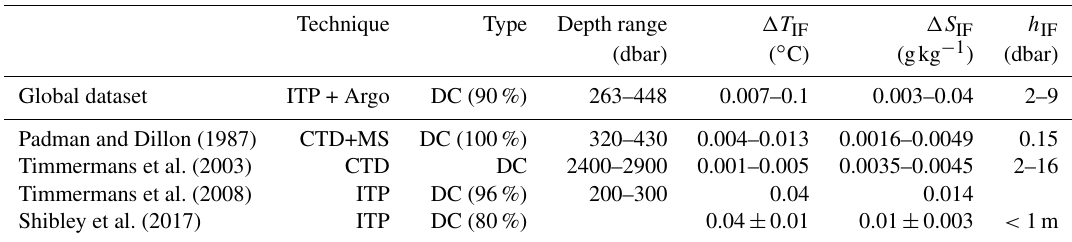
Figure 7. Example conservative temperature profiles selected by the staircase detection algorithm. They are ordered left to right by the number of steps detected. Panel (a) shows examples of increasing steps of diffusive convection. Panel (b) shows examples of the salt-finger regime. Table 3. Characteristics of thermohaline staircases in Canada Basin. The region of the global dataset is confined to 75–80 ◦ N, 135–145 ◦ W. The observational techniques indicate whether the data were obtained from Argo floats (Argo), Ice-Tethered Profilers (ITPs), conductivity– temperature–depth (CTD) measurements, or microstructure measurements (MSs). The dominant type of thermohaline staircases is indicated by DC (diffusive convection) and SF (salt-finger) with the percentage of occurrence between brackets. Ranges of the obtained variables of the global dataset are indicated by means of percentiles 2.5 and